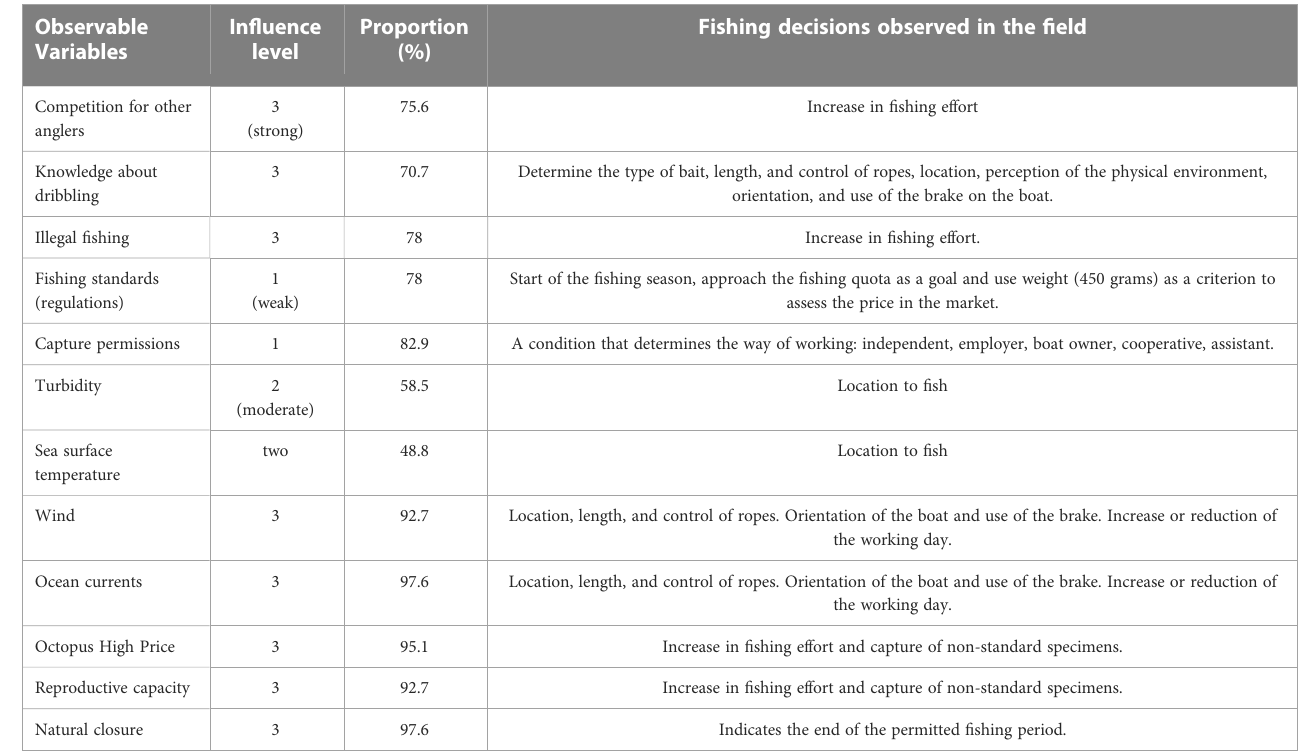
TABLE 1 Observable variables and fi shing